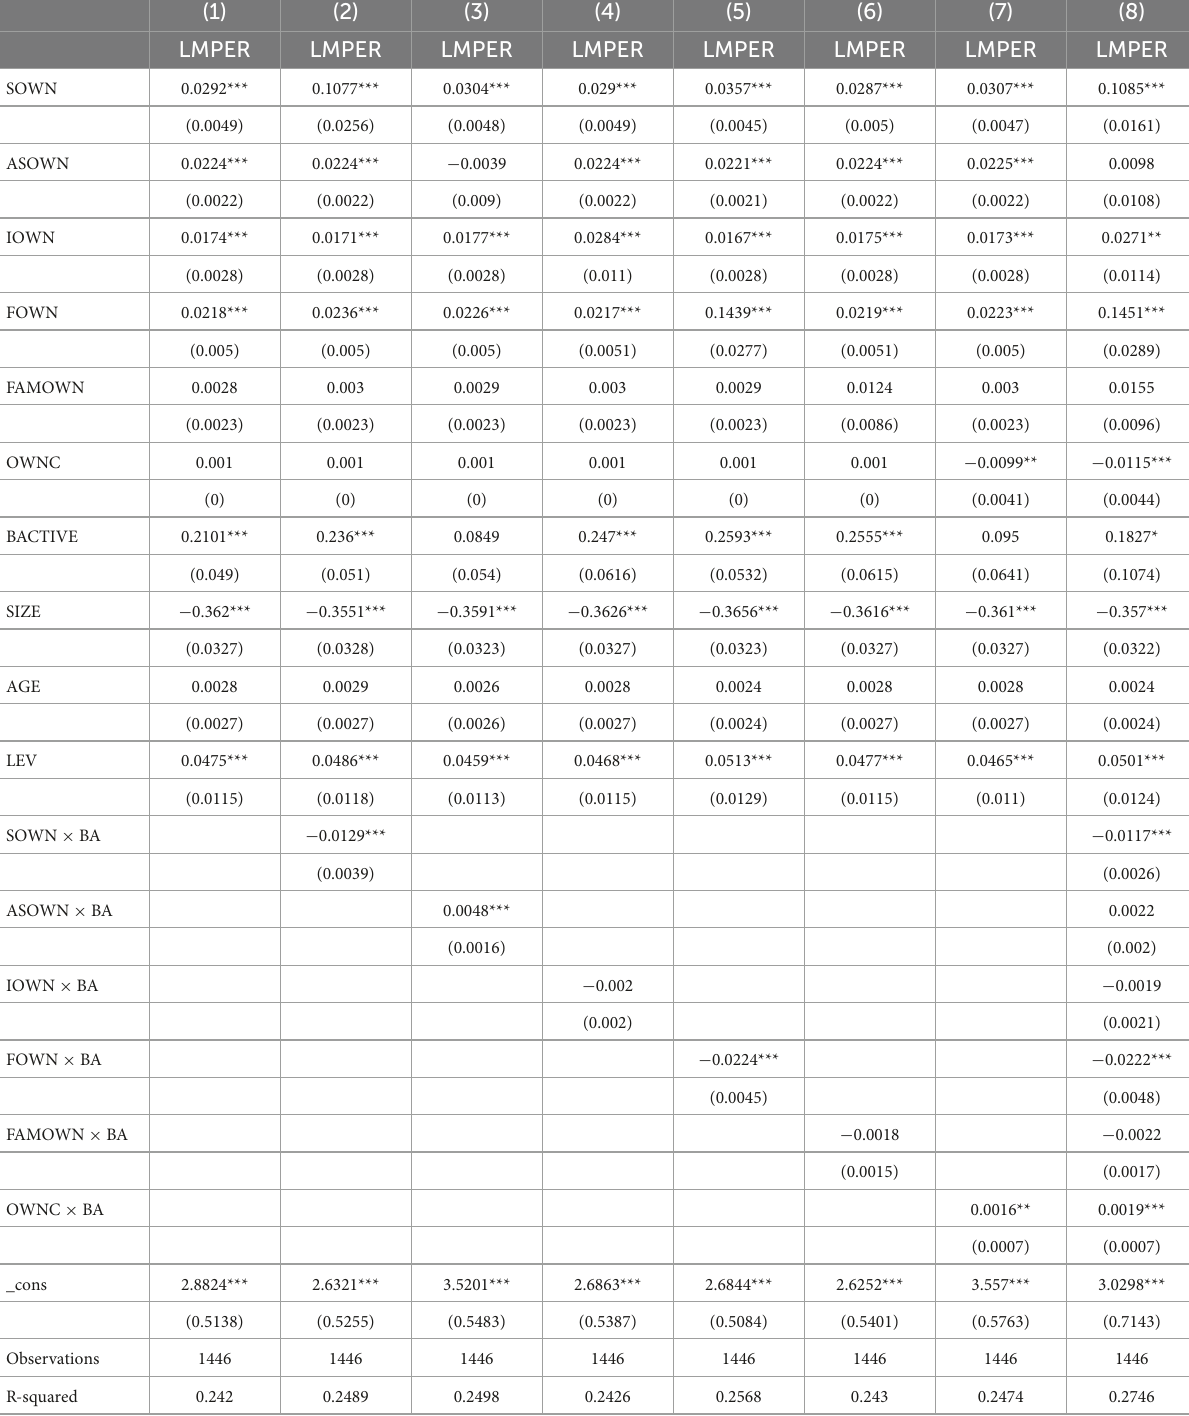
TABLE 6 Regression analysis of stock market